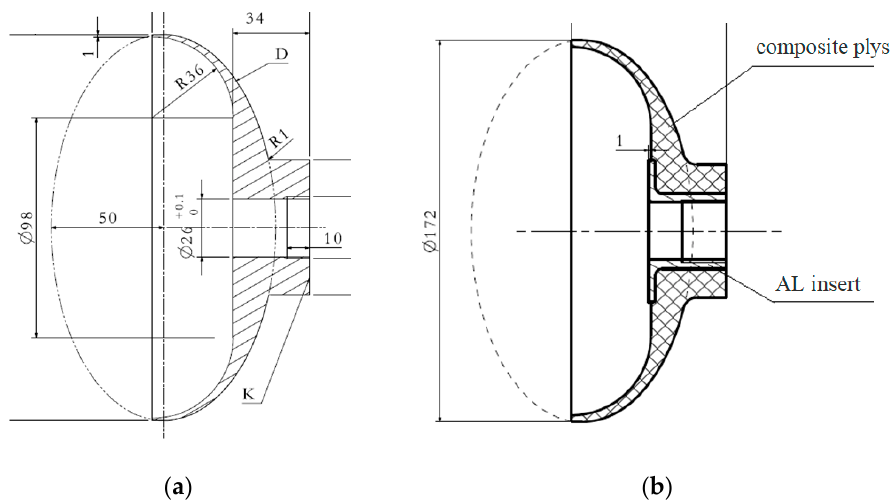
Figure 2. Profile of the RS05A front connector: ( a ) primary front connector ( b ) after first-round optimization. Table 1. Mechanical properties of the